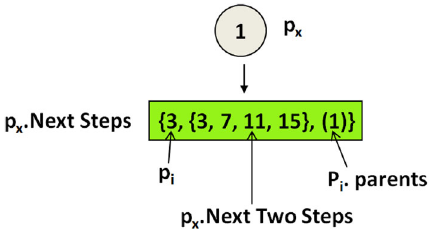
Fig. 7 Example of {pattern#, (next positions), (parents)}